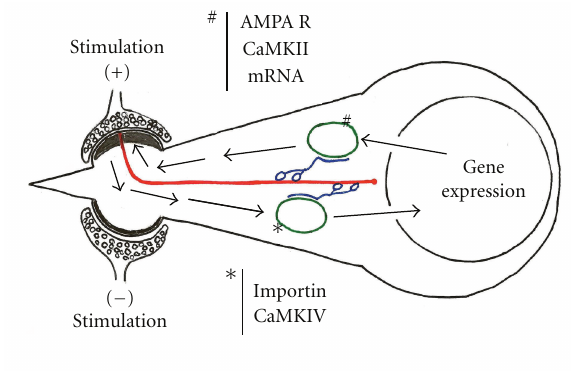
Figure 3: Memory storage. Hypothesis of “endless memory am- plifying circuit” led by the intraspinal microtubules after LTP stimu- lation. Red: